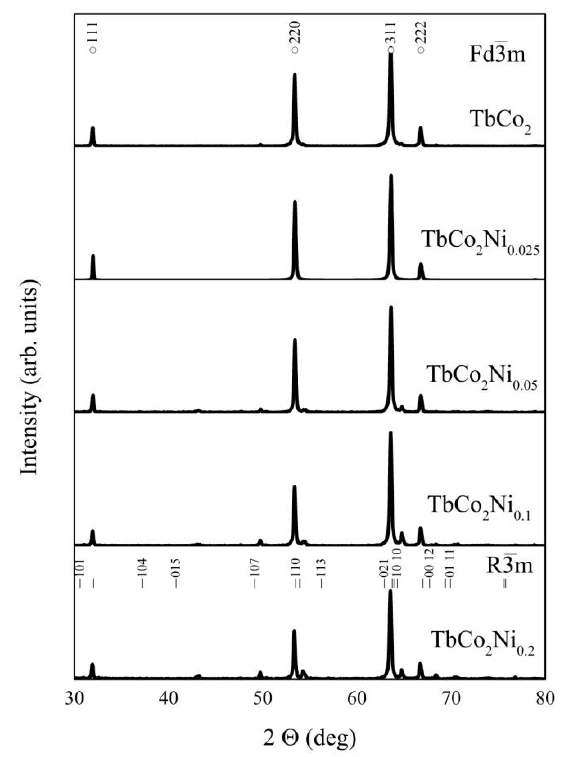
Fig. 1. X-ray diffraction patterns of TbCo 2 Ni x alloys with different x . Bragg peak positions are indicated by the markers for MgCu 2 -type structure (open circles). PuNi 3 -type structures (line bars).